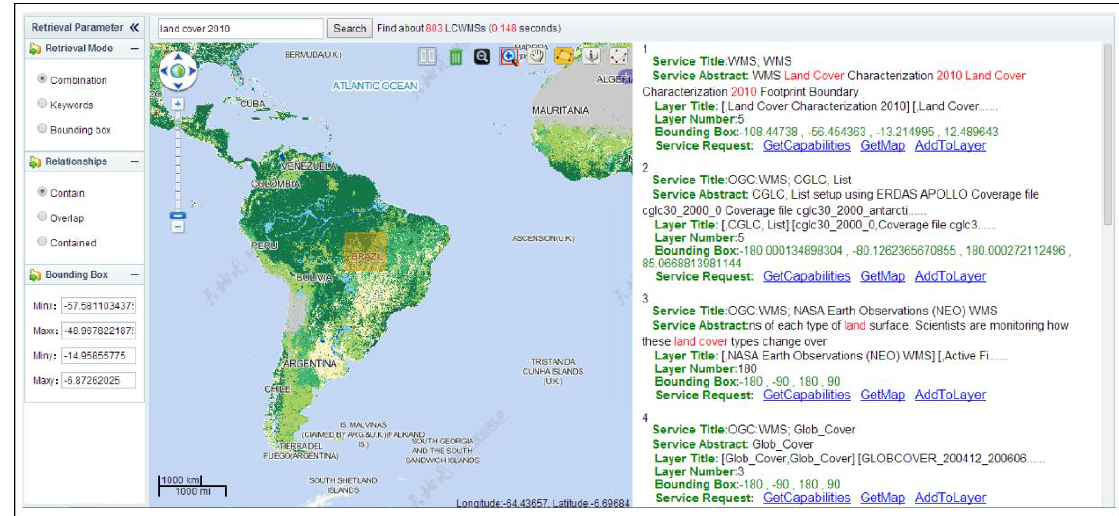
Figure 10. The user interface that displays LCWMSs for the case study.